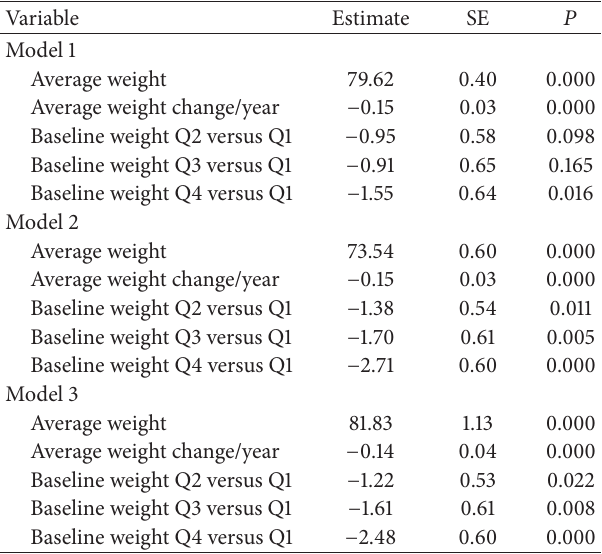
Table 3: Results of the mixed effects model examining the relation- ship between anxiety quartiles and baseline weight (kg).